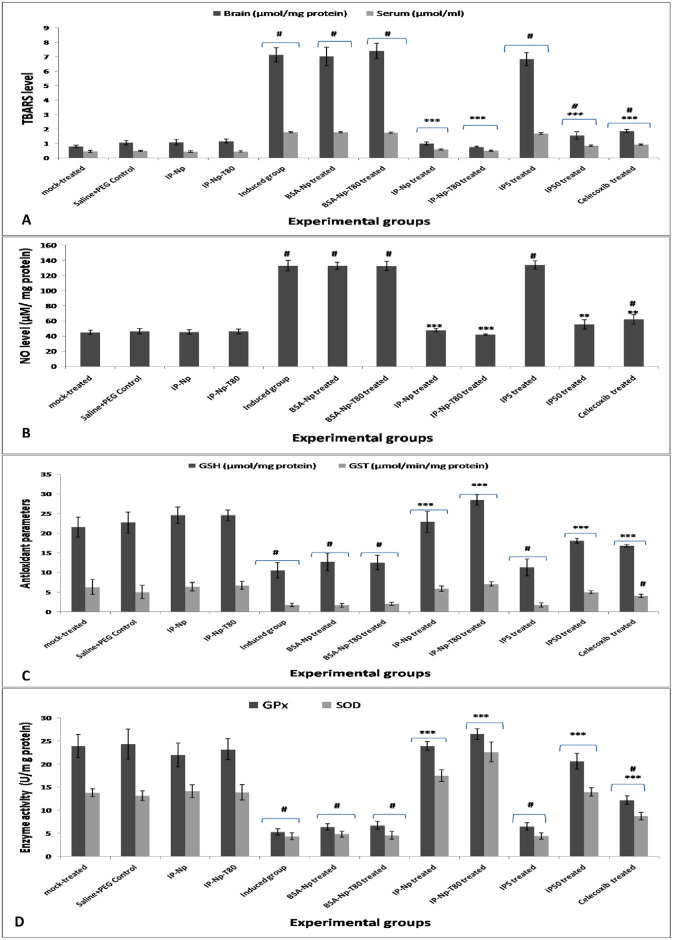
Alterations in oxidative stress parameters.(A) brain and serum TBARS levels, (B) brain NO, (C) GSH levels and GST and (D) GPx and SOD activities in the different experimental groups. Data represented as mean ± SD and p value is statistically significant at (***p≤0.001, **p≤0.01, *p≤ 0.05) compared to induced group and (#p≤ 0.05) compared to mock-treated group.